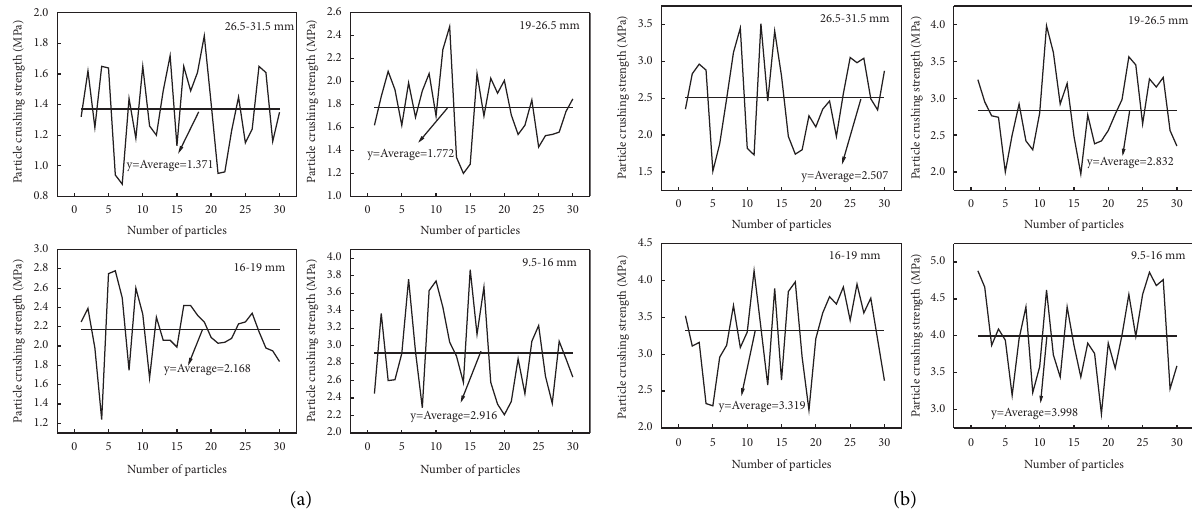
Figure 6: Crushing strength of different recycled aggregate particles. (a) Crushing strength of recycled bricks with different particle sizes. (b) Crushing strength of recycled aggregate particles of concrete with different particle